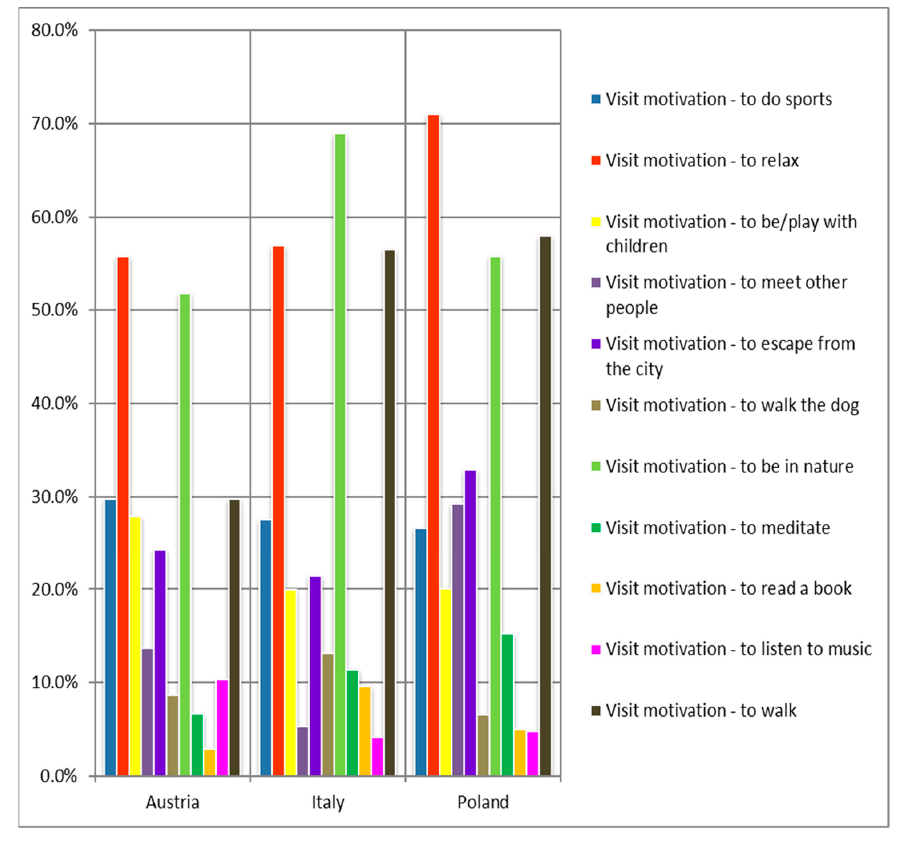
Figure 2. Motives to visit a protected area. Austria, n = 476; Italy, n = 457; Poland, n = 459 ( p ≤ 0.01).